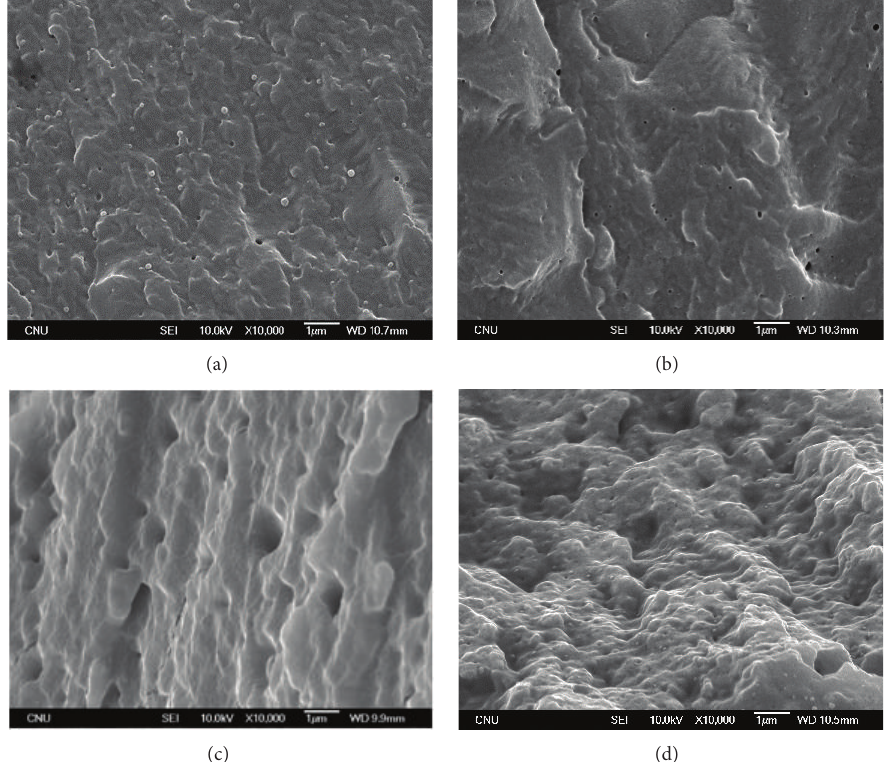
Figure 10: SEM photographs of tensile fracture surface of (a) neat SPI/glycerol film, (b) SPI/glycerol film with PVA (5wt%), (c) SPI/glycerol film with PVA (15wt%), and (d) SPI/glycerol film with PVA